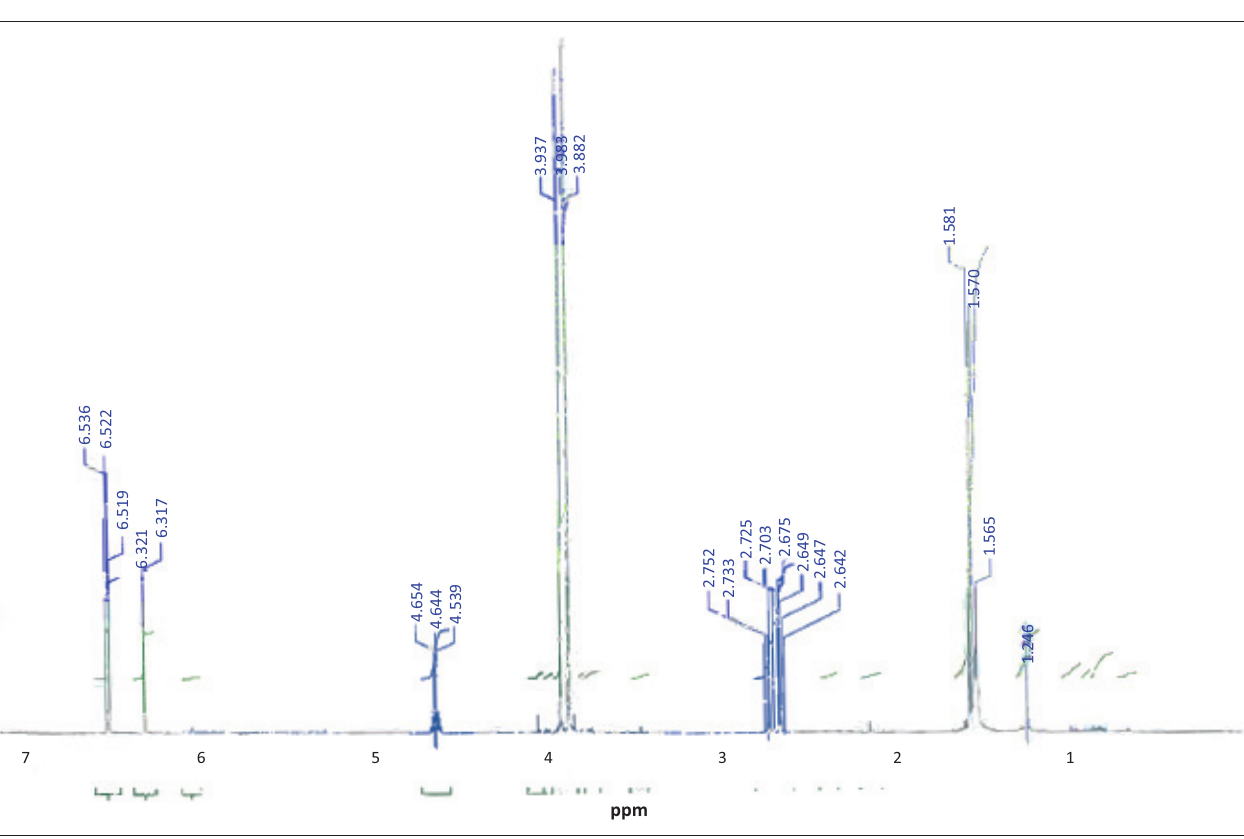
FIGURE 4: 1 1 H-NMR spectral data (600MHz, CDCl3) of sub-fractions of the dichloromethane fraction of G. senegalensis showing a doublet at δ 1.57, a multiplet at δ 2.69, three singlets at δ 3.94 - 3.89, and a multiplet at δ 4.64.